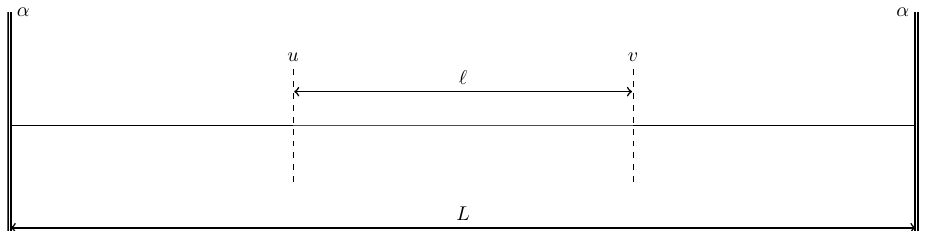
Figure 1: A generic bipartition of a 1D system with boundary condition α on both